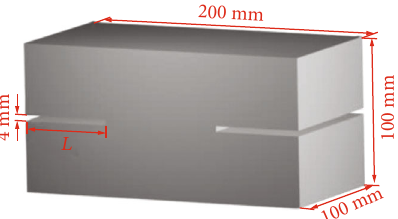
Figure 2: Specimen dimension schematic diagram ( L : crack